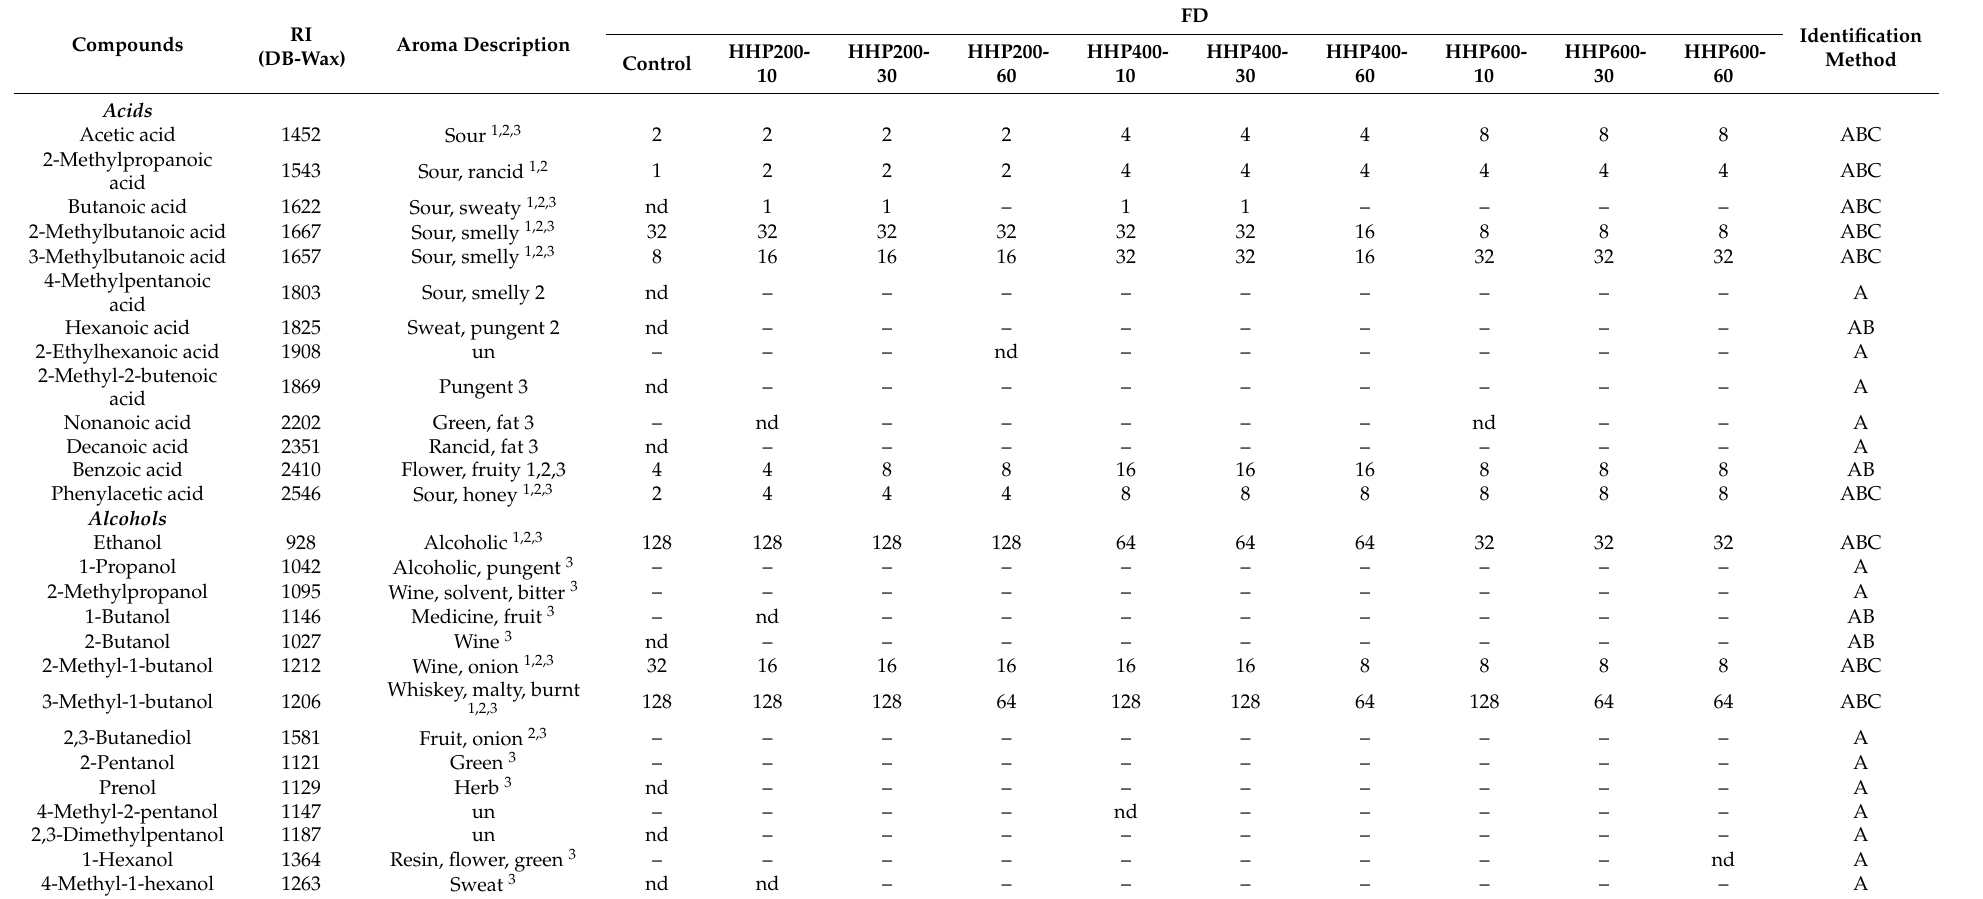
Table 1. Volatile compounds identified in the control and